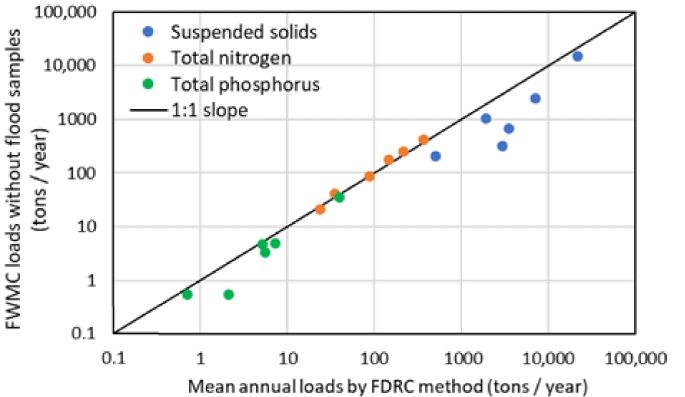
Figure 18. Comparison of the mean annual loads calculated using the FDRC and FWMC methods without the flood samples for the FWMC method (plotted on a log